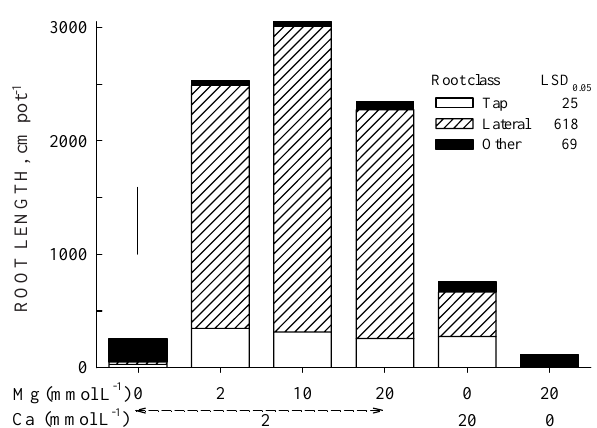
Figure 4. Total root length at harvest as a function of root classes and solution Ca and Mg treatments in the subsurface compartment for soybean cv. Ransom in Experiment 2. All solution treatments were maintained at pH 4.6 and contained 15 µmol L -1 Al. Vertical bar denotes least significant difference (p < 0.05) among treatments for total root